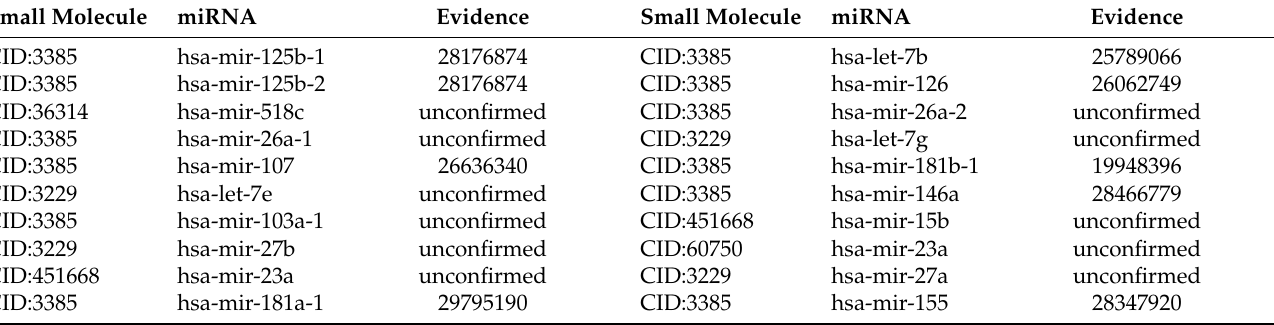
Table 5. The top 20 SM–miRNA associations predicted by AMCSMMA in the first type of case study. Small